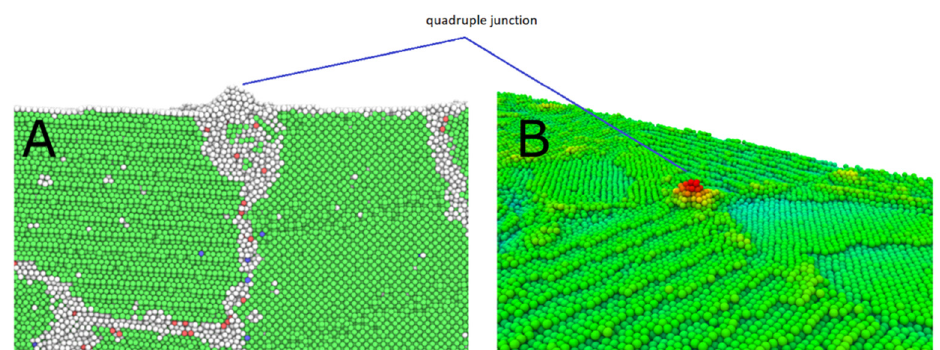
Figure 4. The cross section ( A ) and a perspective view ( B ) of a surface protrusion. Atoms are colored by the PTM parameter. Video S1 of the protrusion formation is given in Supplementary Materials.